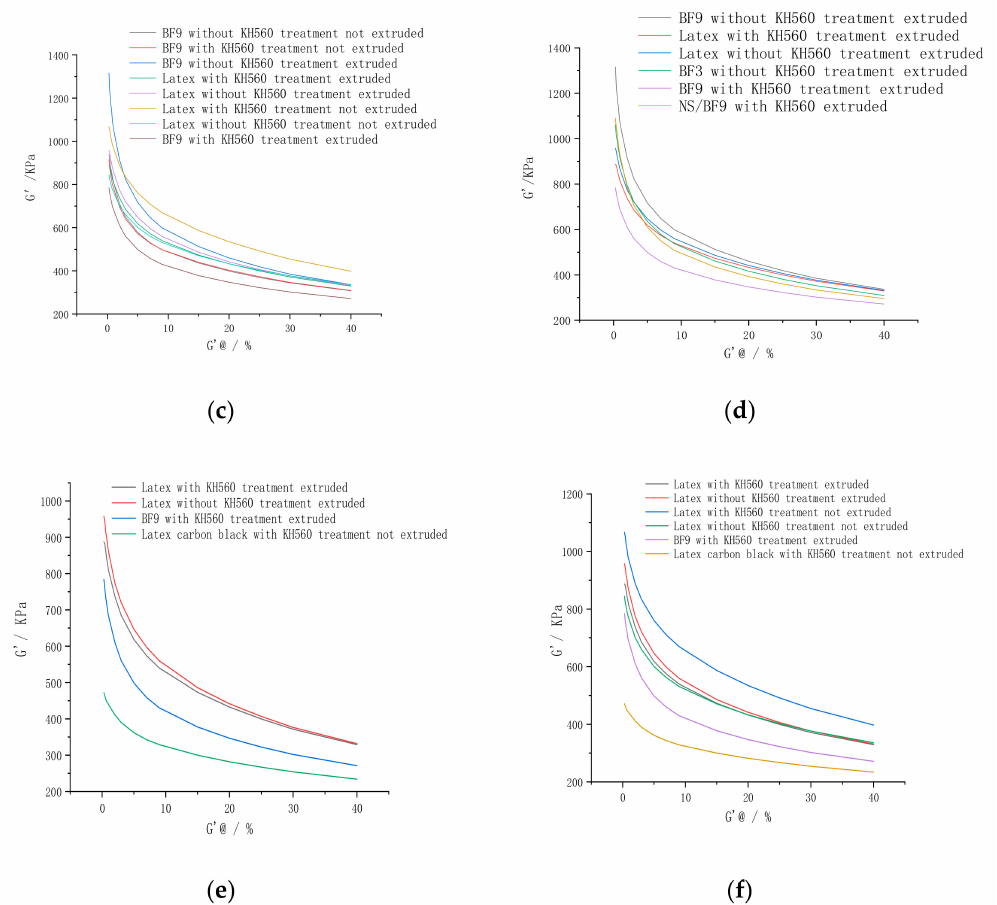
Figure 15. Results of RPA tests. ( a – f ): Viscoelasticity Curves of the